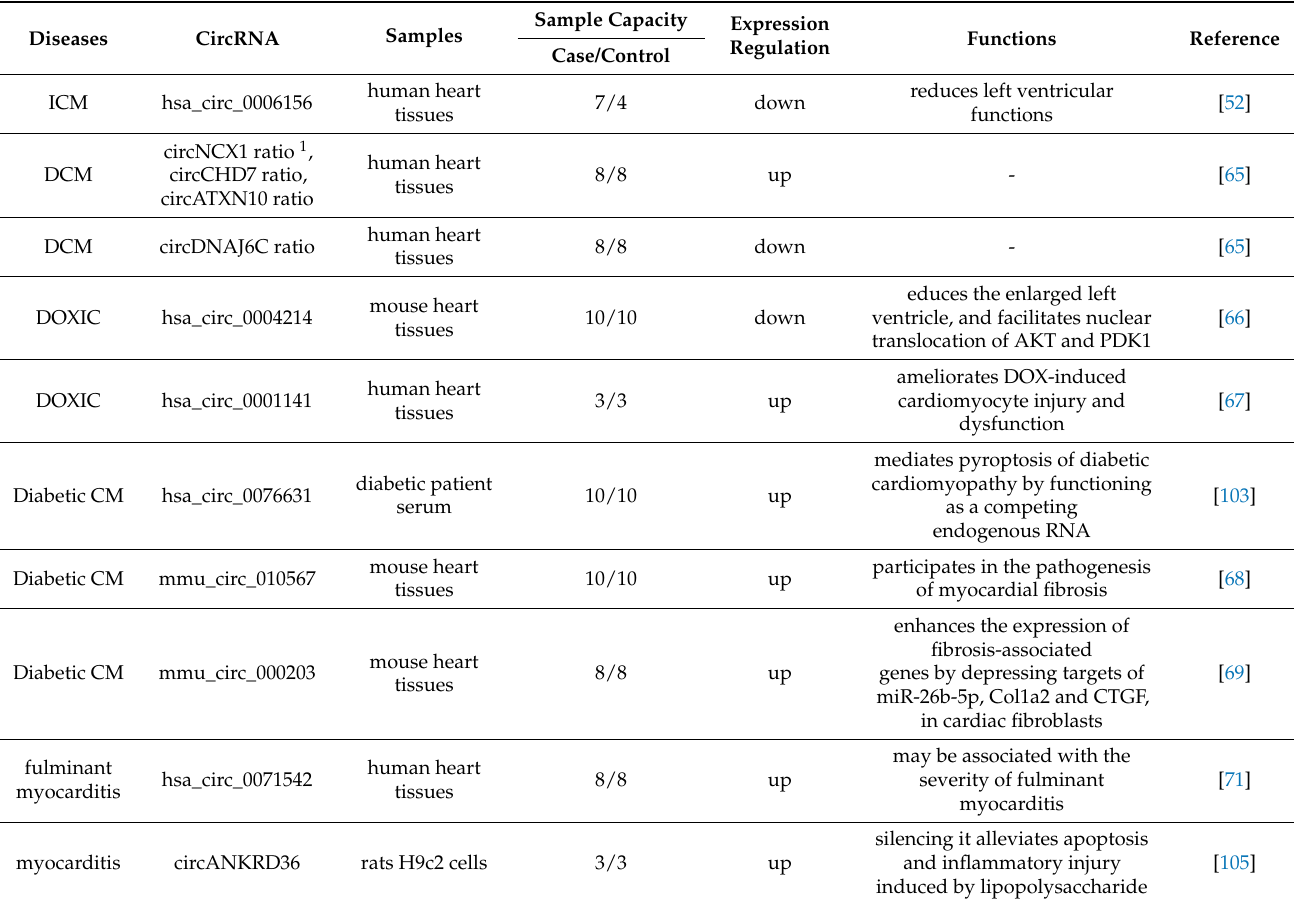
Table 6. CircRNAs as potential biomarkers in cardiomyopathies and myocarditis validated by real-time RT-qPCR. Sample Capacity Expression Diseases CircRNA Samples